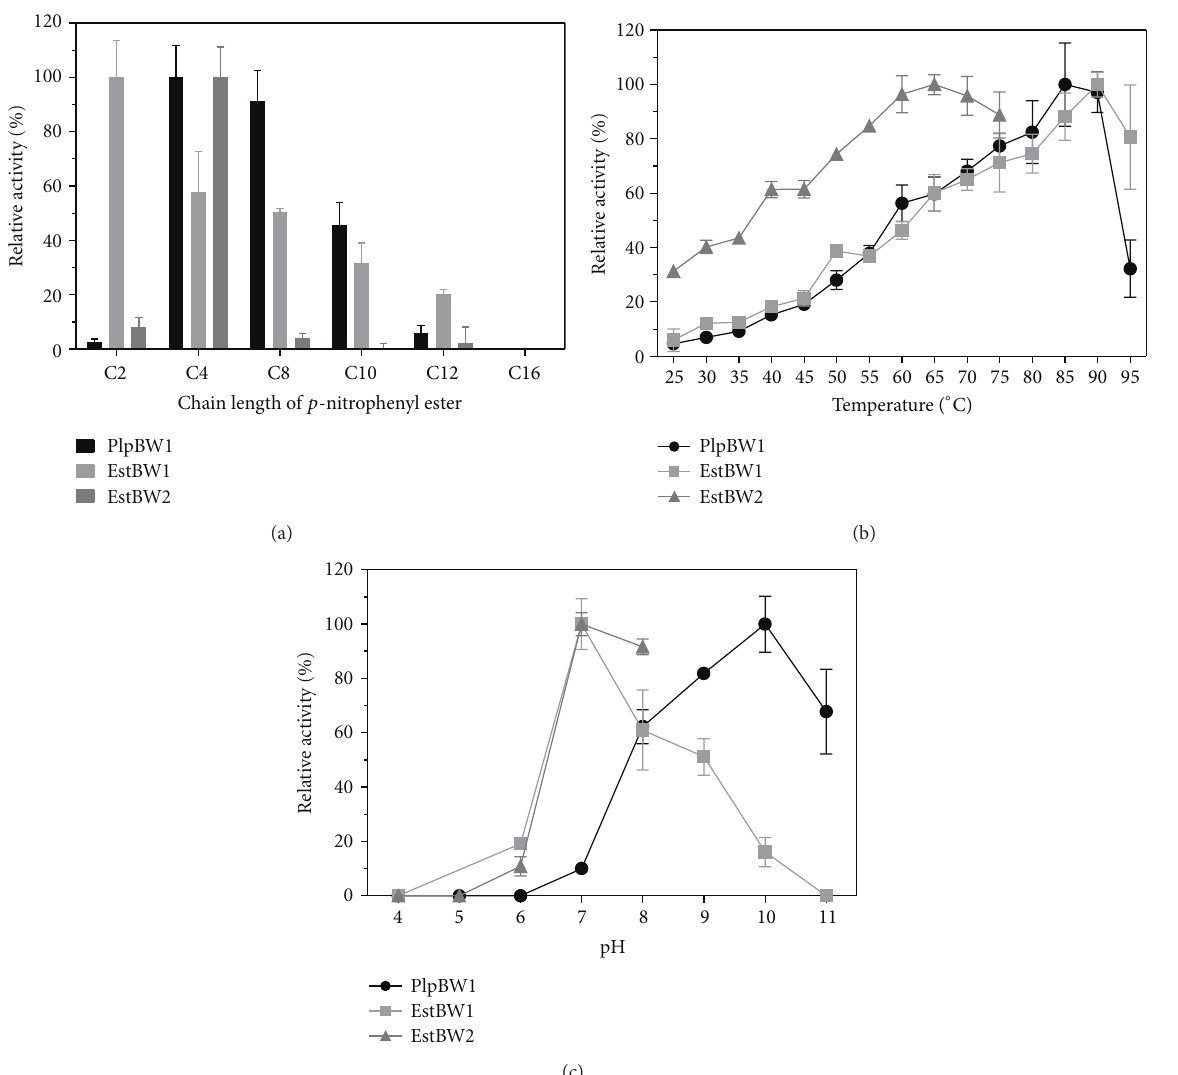
Figure 5: Relative activities of the three lipolytic enzymes towards different p -nitrophenyl esters with various chain lengths (a), at different temperatures (b), and pH values (c). The activity of estBW2 could not be measured above 75 ∘ C and pH 8 due to the instability of the p -NP butyrate under these